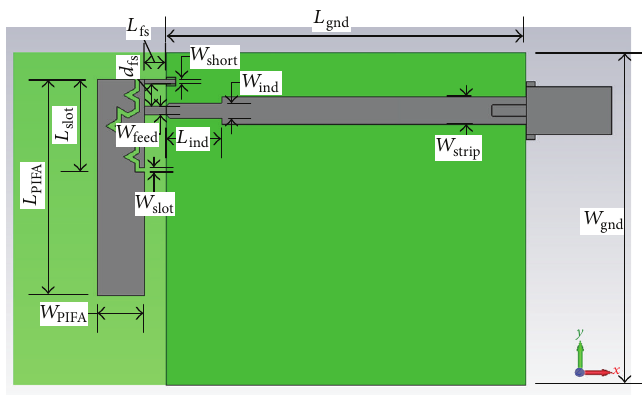
Figure 1: Parametric breakdown of the printed IFA loaded with an embedded Koch-shaped slot. The substrate is transparent, showing the ground plane on the bottom layer. The nomenclature of parameters is a simplified version of the one used in [26].